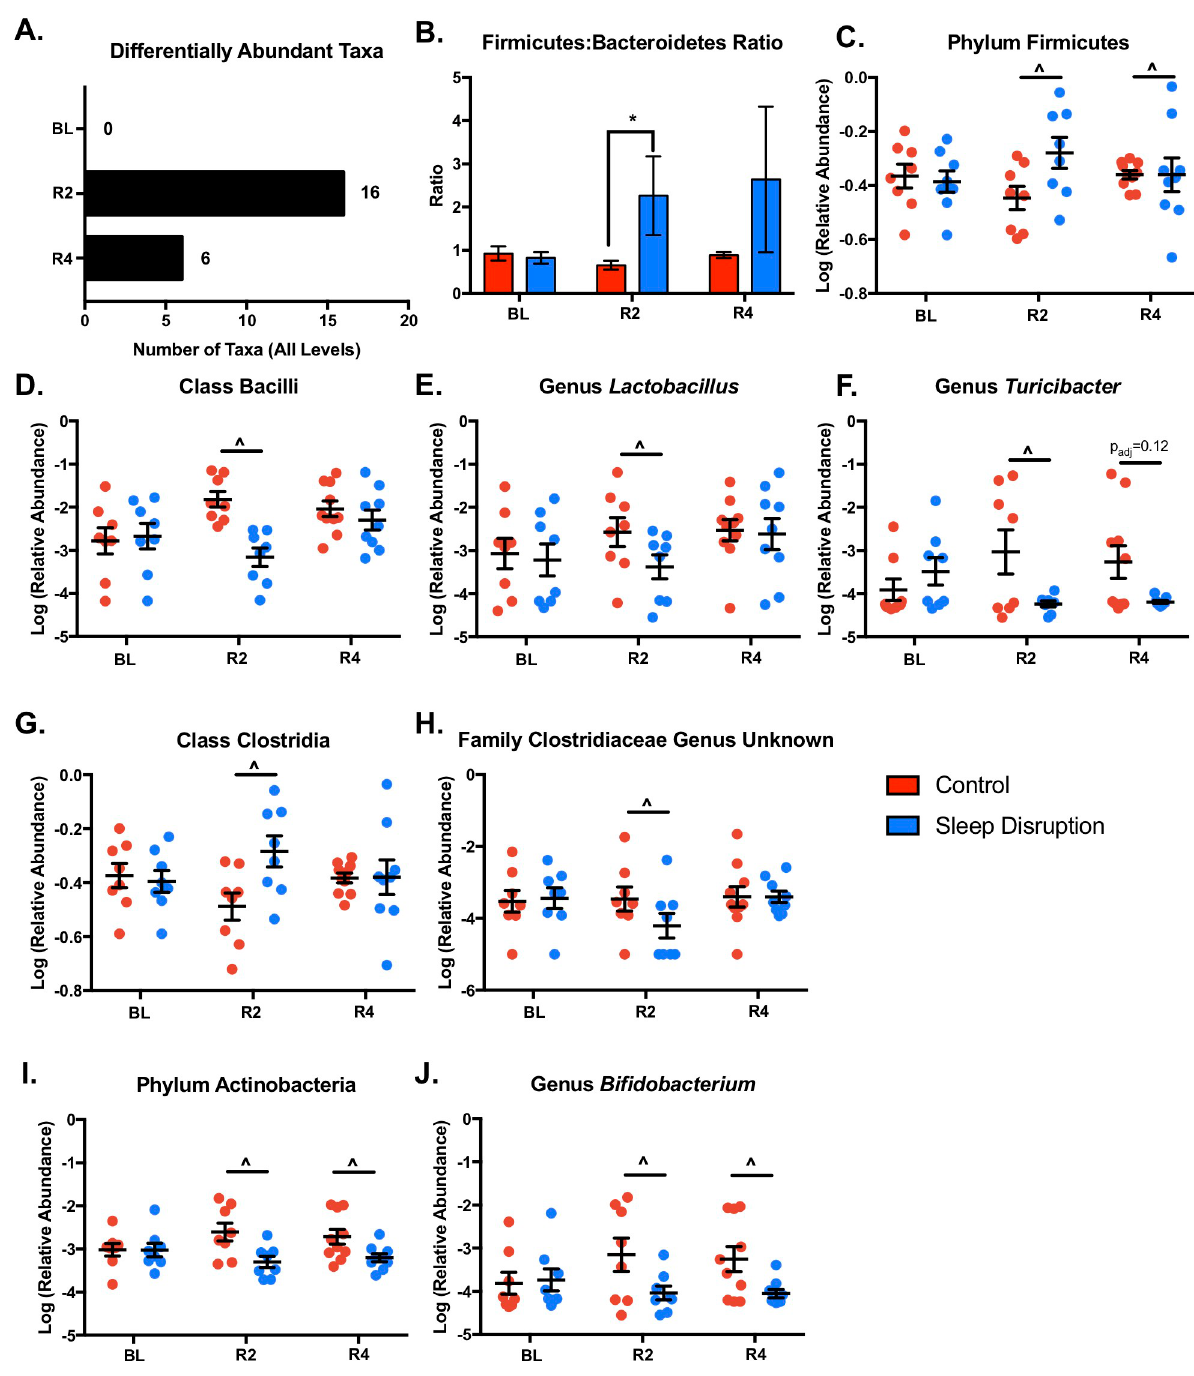
Fig 4. Effect of sleep disruption on individual microbial taxa. At each timepoint, DESeq2 was performed at each taxonomic level to identify taxa differentially abundant between sleep disrupted and control groups. A) Summary of significantly different taxa by timepoint. B) The ratio of relative abundances of the phyla Firmicutes to Bacteroidetes was significantly increased at day 2 post-sleep disruption in sleep-disrupted animals. This increase was mostly driven by a significant increase in Firmicutes (C). Within the Firmicutes phylum, the class Bacilli (D), genus Lactobacillus (E), and genus Turicibacter (F) were reduced at day 2 post-sleep disruption. The class Clostridia was increased (G) and an unknown genus within the Clostridiaceae family (H) was decreased in sleep-disrupted animals at day 2 post-sleep disruption. Both the phylum Actinobacteria (I), and the genus Bifidobacterium (J) were decreased at day 2 and day 4 post-sleep disruption in the sleep disrupted group. Abbreviations: BL, baseline; R2, day 2 post-sleep disruption; R4, day 4 post-sleep disruption. n = 8-10/group. Data represent means ± SEM. � p < 0.05 (Wilcoxon Rank-Sum Test); ^FDR < 0.1 (DESeq2).